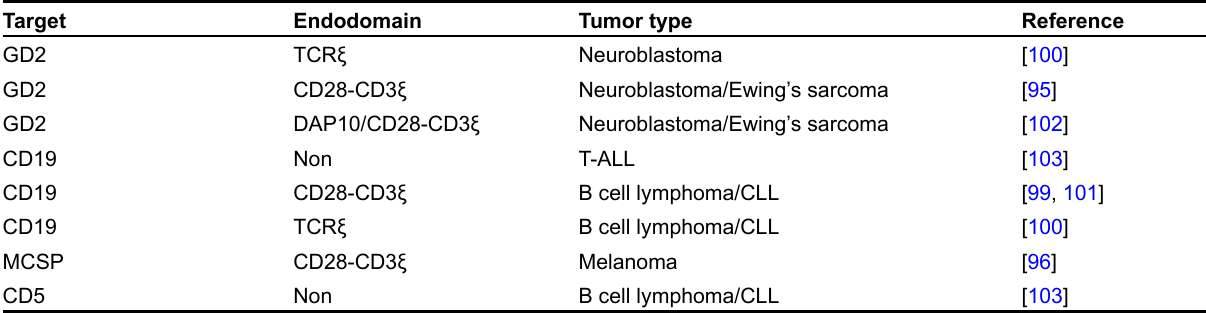
immunotherapy is listed in Table 3. Table 3. CAR-γδ T cell-based